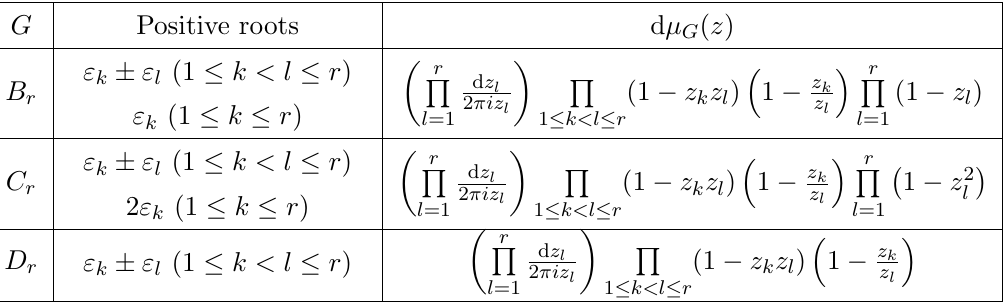
Table 2 . Measures on maximal tori of various algebras appearing in the Weyl integration